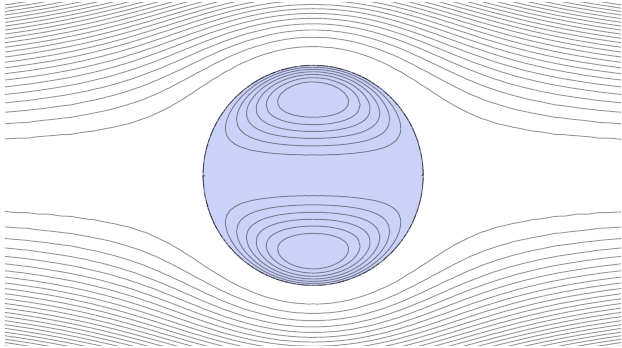
Figure 3. Streamlines in the symmetry plane for uniform flow past a fluid drop. The radius of the fluid drop is d = 1 and the viscosity ratio ¯ µ / µ =